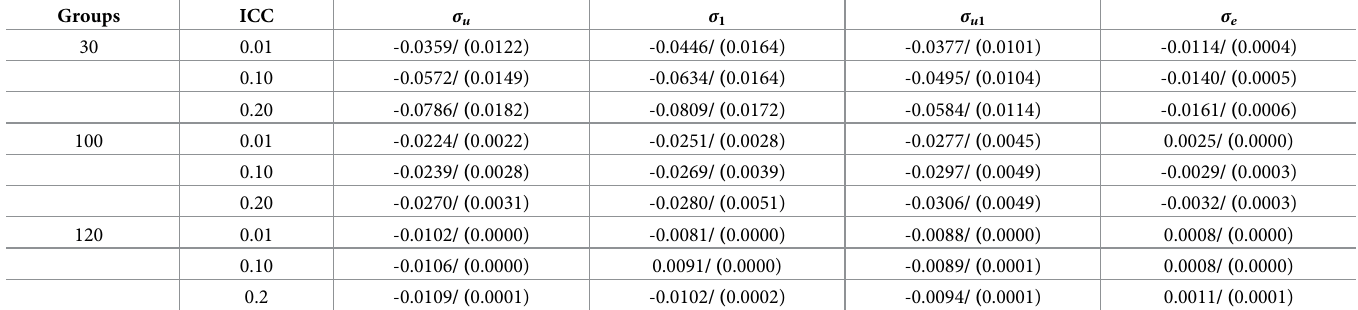
Table 8. Average relative parameter bias of the random effect estimates obtained for exponential distribution data (First = REML estimation procedure, Second = Bootstrap estimates are enclosed in parenthesis). Groups